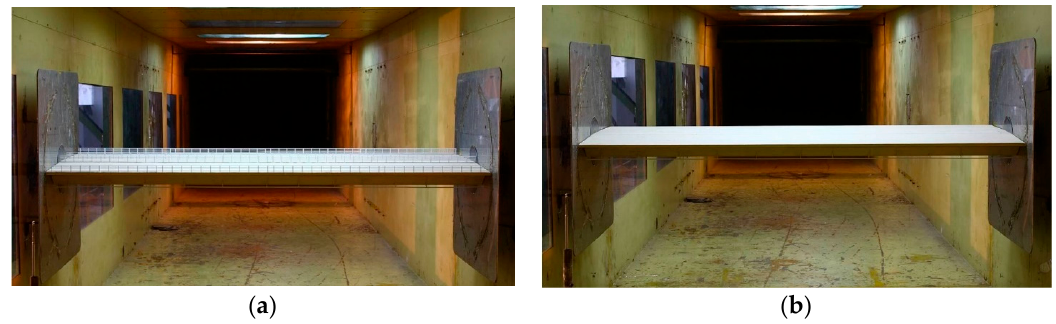
Figure 2. The test models for force measurements: ( a ) the test model in the operation stage; and ( b ) the test model in the construction stage.